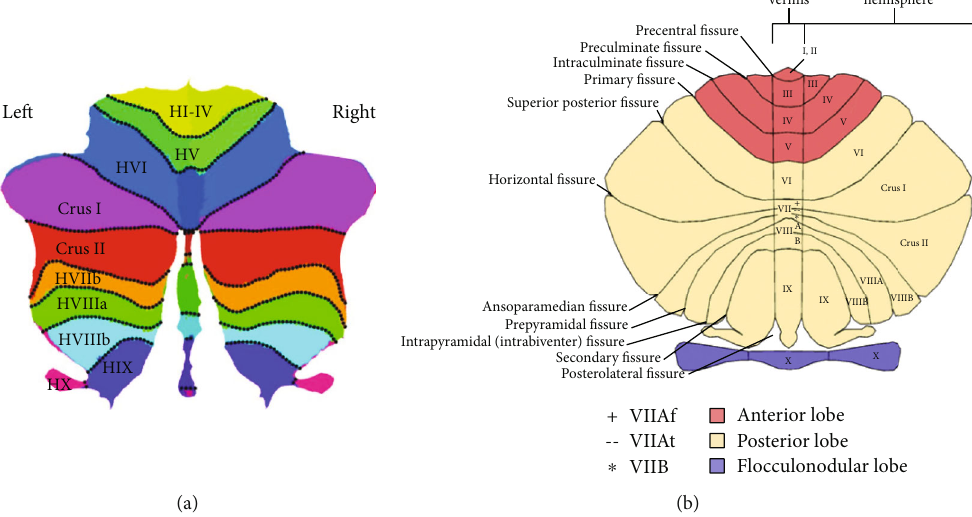
Figure 1: Flattened representation and illustration of the cerebellum and its major fi ssures, lobes, and lobules. Description: (a) Flattened representation of the human cerebellum developed by Diedrichsen et al. [105] In contrast to the vermis parts in the middle of the fl at map, H stands for “ hemispheric. ” (b) The anterior lobe is colored red; the posterior lobe is cream and the fl occulonodular lobe is purple. In the lobule VII, the VIIAf at the vermis expands in the hemisphere to become the Crus I. The lobule VIIAt at the vermis merges with the Crus II in the hemisphere, whereas the lobule VIIB retains its structural integrity both at the vermis and in the hemispheres. Author ’ s diagram adapted from Schmahmann et al. [106] and fi rst published in D ’ Mello et al. [107].